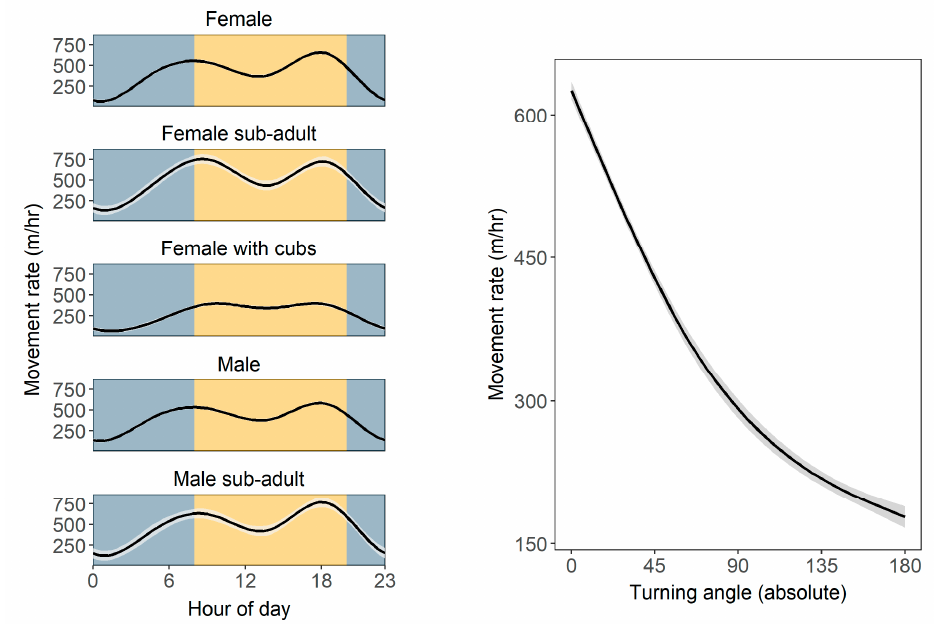
Figure 3. Observed movement rate patterns across all grizzly bear locations by time of day for each age-sex-reproductive class ( left ) and by turning angle ( right ).